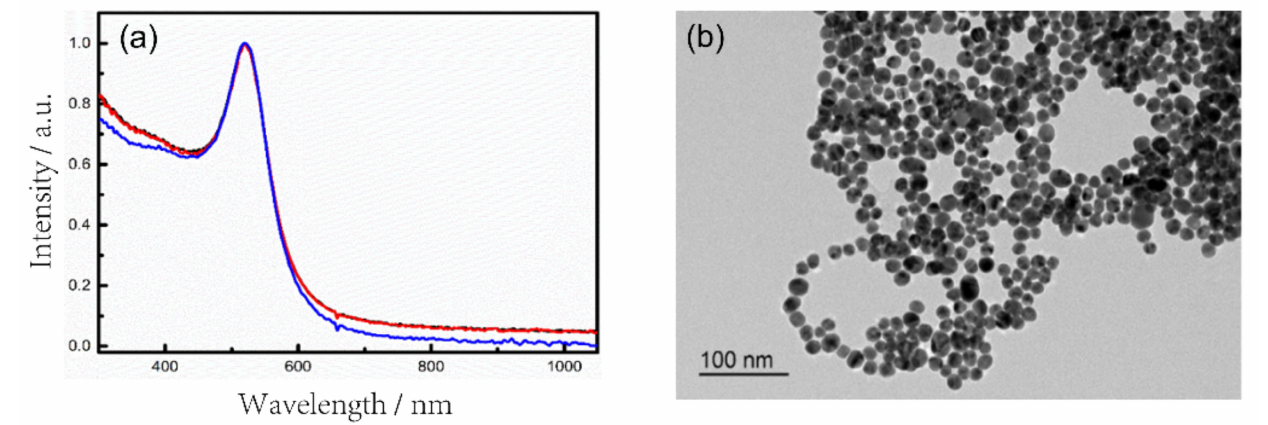
Figure 4. ( a ) UV-Vis absorption spectra of the Au NPs colloid solution; ( b ) TEM image of Au